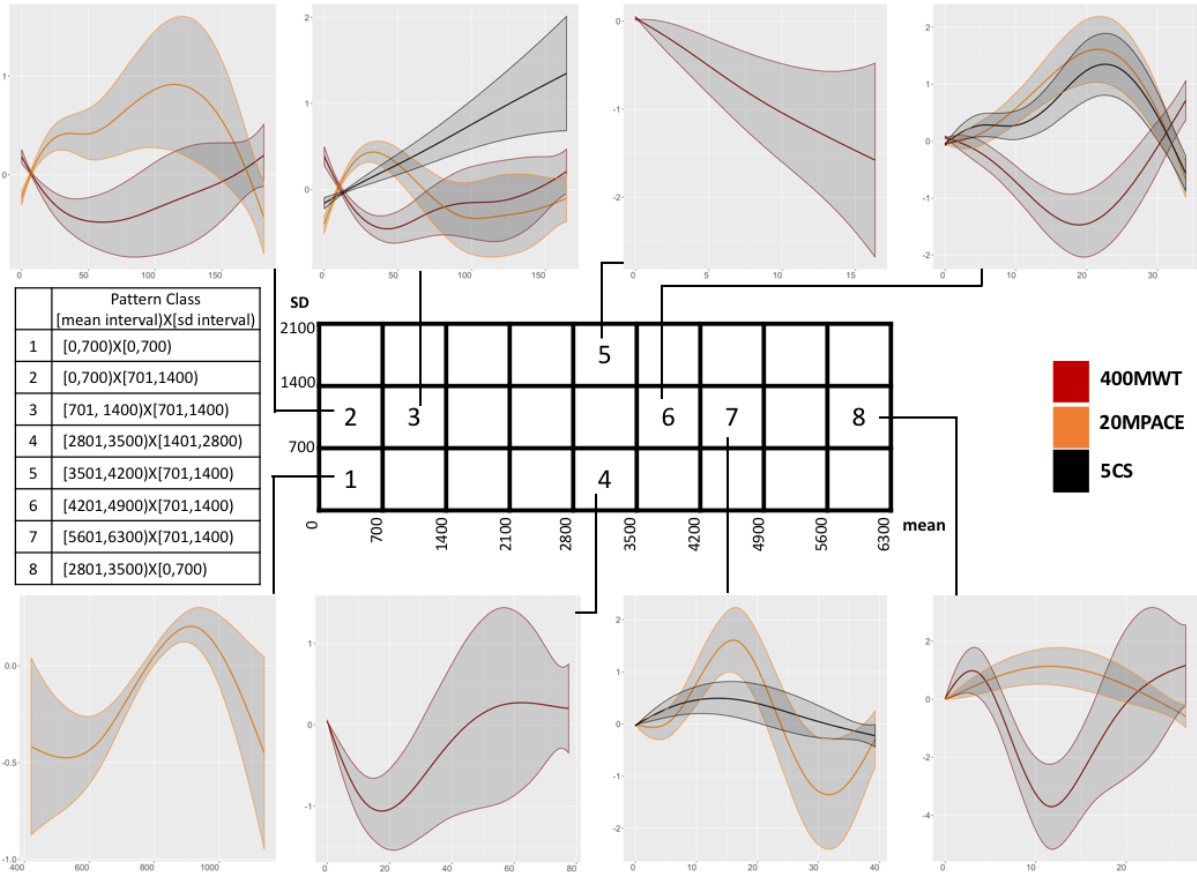
Figure 6. The grid boxes represent pattern classes labeled with the mean interval (x-axis) and the SD interval on the y-axis. 400MWT: 400-m